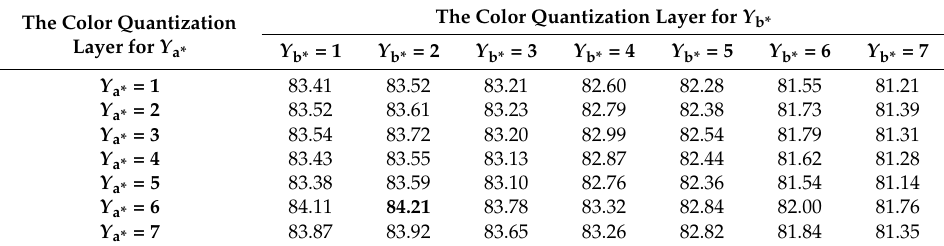
Table 4. Average precision rate (APR) of different color quantization layers on Outex-00014. The Color Quantization Layer for Y a*